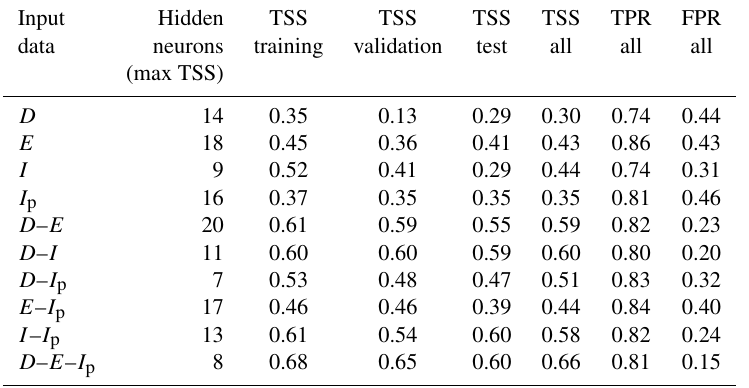
Table 1. Results of tests with ANNs, showing the optimal number of hidden neurons (a number from 5 to 20 has been tested) and the true skill statistics (TSSs) for the entire, the training, the validation, and the test data sets. Values in the table are compared to TSS 0 = 0 . 50, which is the maximum value associated with a D – E power law